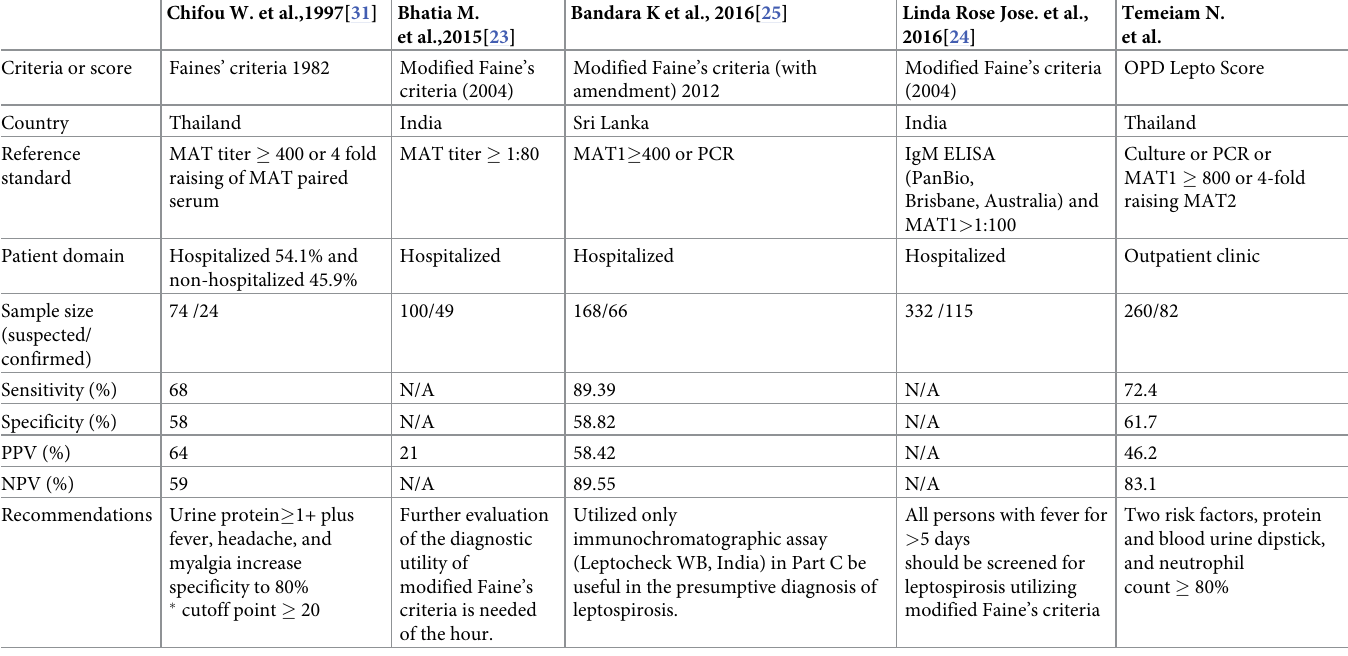
Table 6. Comparison of study characteristics and diagnostic indices between previous diagnostic criteria of leptospirosis and newly derived OPD Lepto